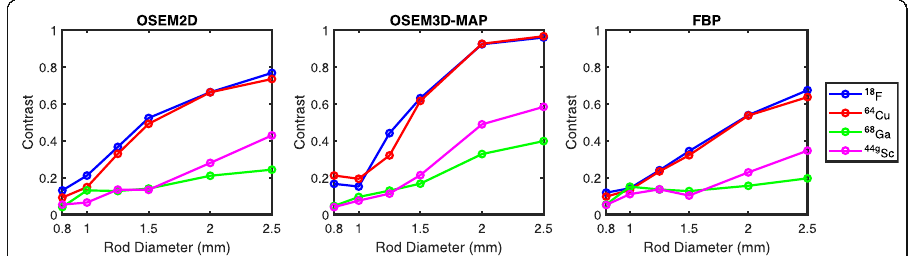
Fig. 6 Normalized contrast as a function of rod